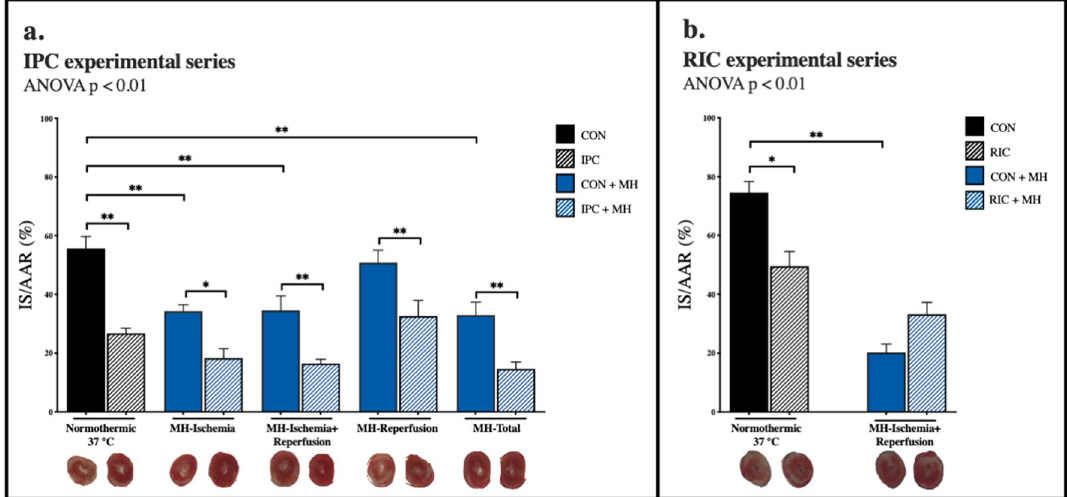
Figure 2. Infarct size. ( a ) IPC experimental series, ( b ) RIC experimental series. IS/AAR Infarct size/area at risk, CON control, IPC ischemic preconditioning, RIC remote ischemic preconditioning, MH-Ischemia mild hypothermia during ischemia, MH-Ischemia + Reperfusion mild hypothermia during last 20 min of ischemia and throughout reperfusion, MH-Reperfusion mild hypothermia during reperfusion, MH-Total mild hypothermia through the total protocol. *p < 0.05, **p <